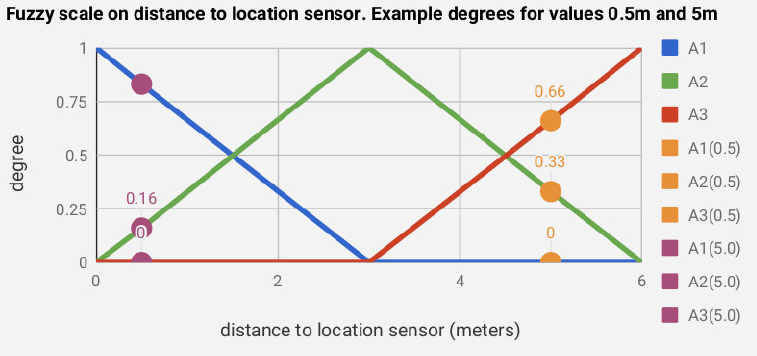
Figure 4. Example of the fuzzy scale defined for g = 3 on distance to the location sensor. Example degrees = 0.5 m, v t = 0, = 5.0 m } → A ( t ∗ ) = { A for values evaluating the distances S i ( t ∗ ) = { v t 1 1, t 1 2 1 = 0 } = 0.66, A = 0.16 } , A ( t ∗ ) = { A = 0.33, A = 0.83 } , A ( t ∗ ) = { A A 1, t 3, t 2 3 3, t 1 2, t 2 2 2, t 1 2